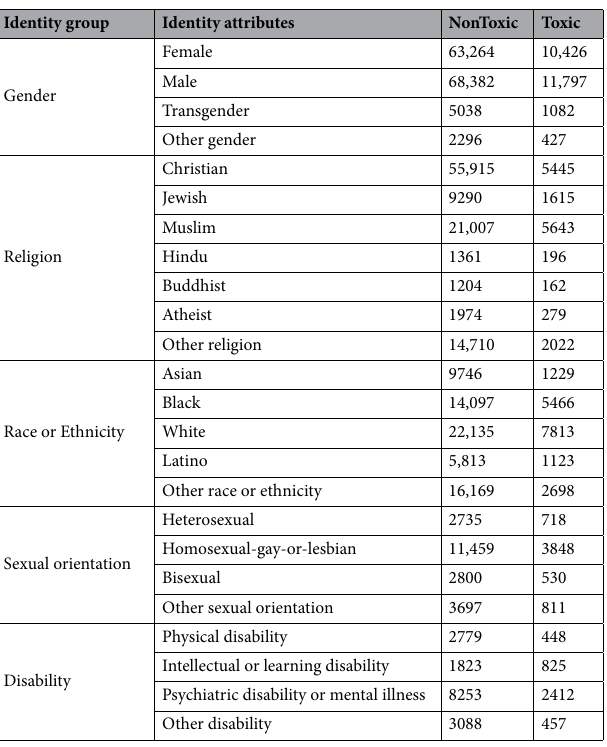
Table 1. Distribution of subgroup comments in unintended bias in toxicity classification